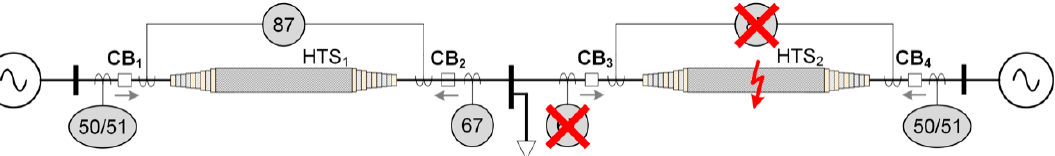
Figure 22. HTS cable temperatures in case DCR fails: ( a ) HTS 1 ; ( b ) HTS 2 .